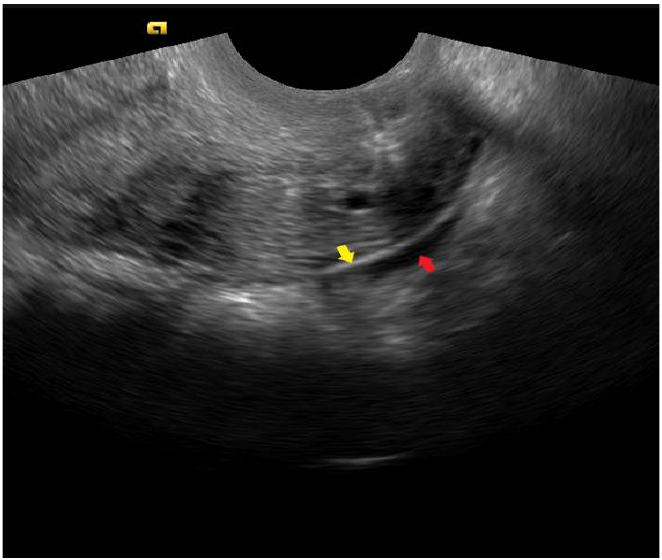
Figure 6. In the sagittal plane, the stretched, normal uterosacral ligament (yellow arrow) appears as a thin white line. The presence of a small amount of free fluid (red arrow) facilitates the visualization.